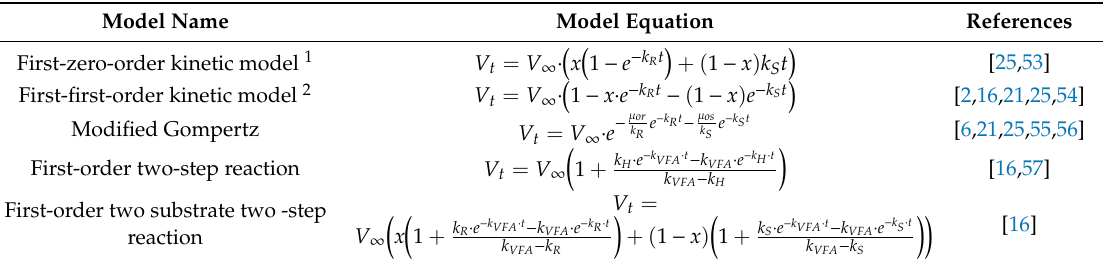
Table 2. Biomethane formation models for multi-step